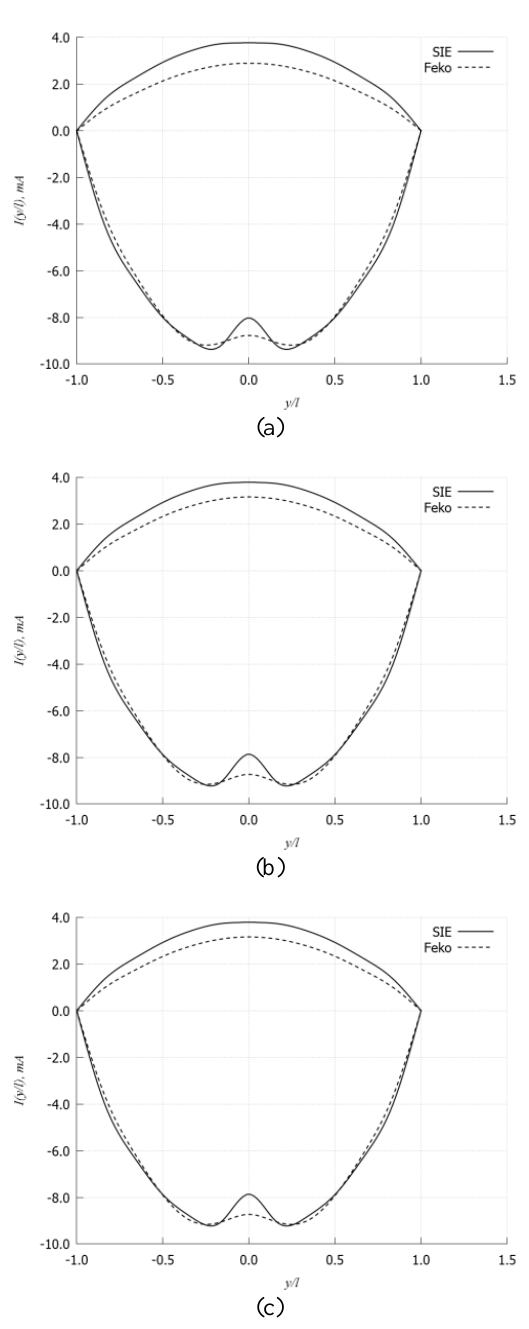
Fig. 2. Current distribution functions for the first (a), second (b) and third (c) vibrators with in-phase